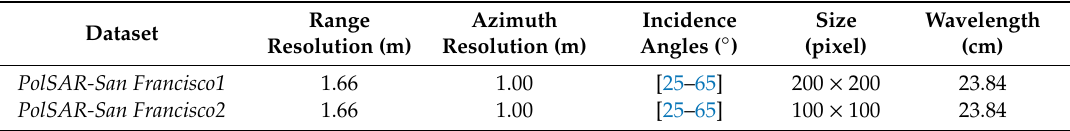
characters are the name of datasets). Table 3. The description of the Polarimetric Synthetic Aperture RADAR (PolSAR) datasets (italic